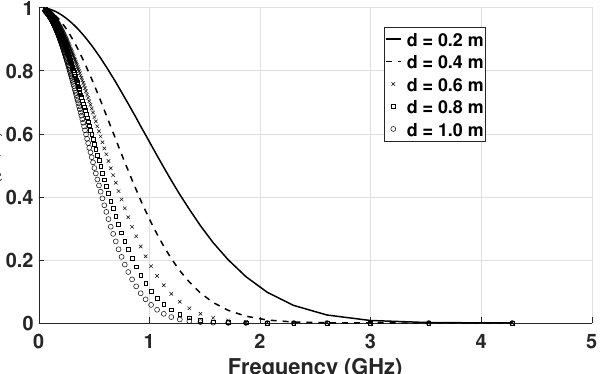
Figure 4. Transmittance as a function of frequency between 0.2–4.2 GHz with v wt = 0.3 and d between 0.2 and 1 m.